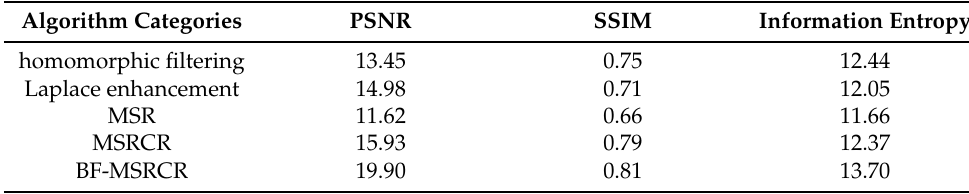
Table 1. Evaluation criteria for downhole image enhancement effect. Algorithm